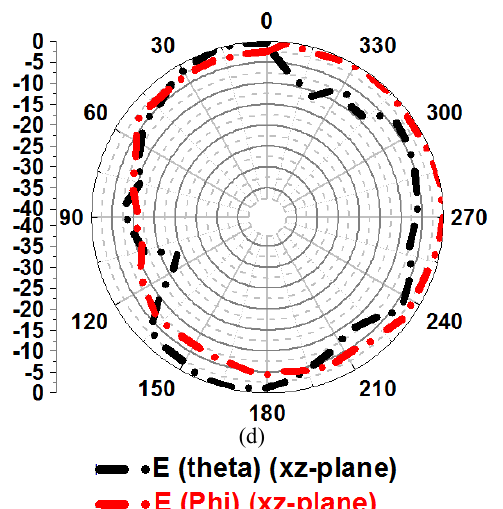
Figure 11. Measured xz-plane normalized radiation pattern for (a) 2.56, (b) 5.39, (c) 6.97 and (d) 8.08 GHz